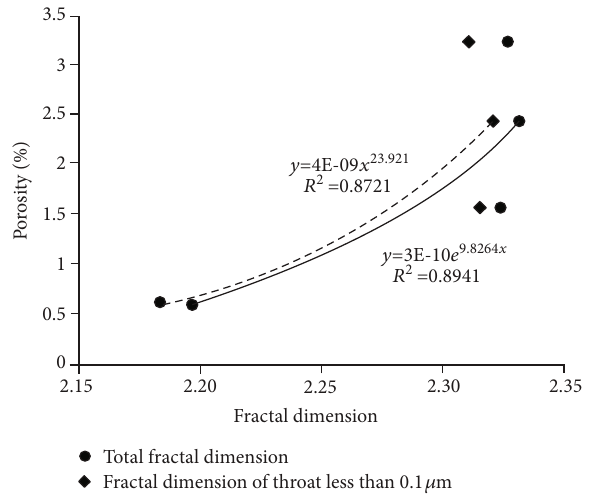
Figure 3: Relationship between fractal dimension of pore throats and porosity.